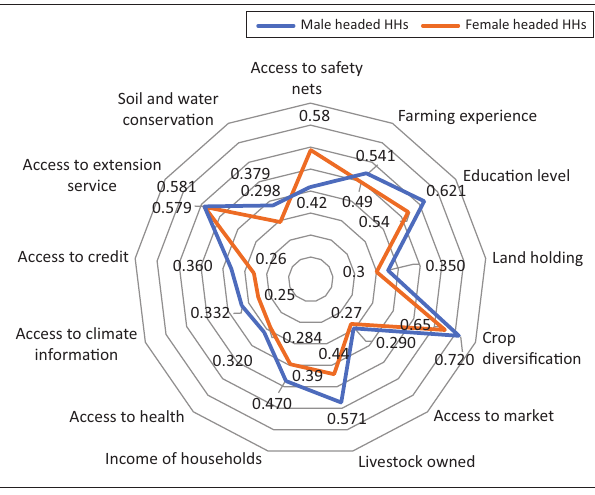
HH, household head. FIGURE 2: Factor loadings of observed variables of adaptive capacity of households.